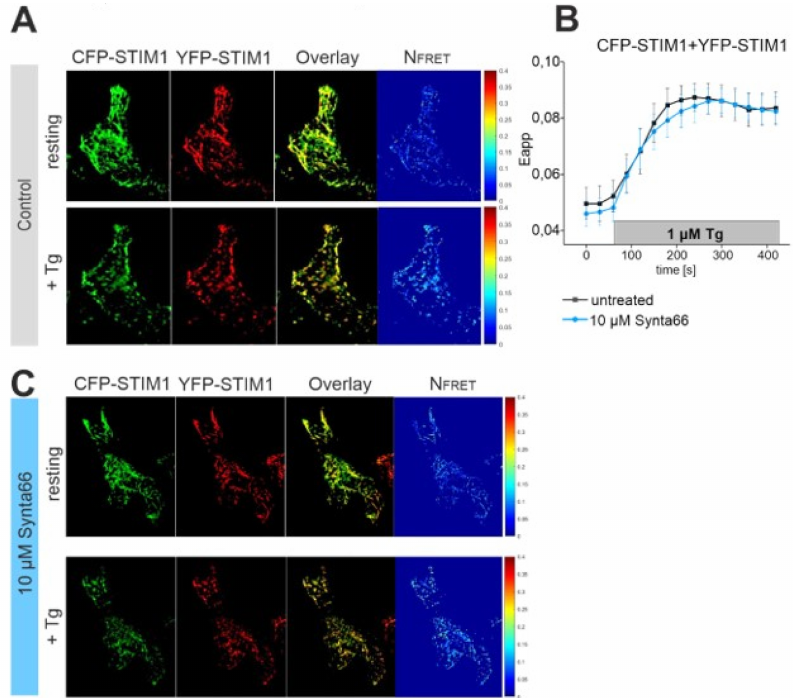
Figure 4. STIM1 interaction is not a ff ected by Synta66 : ( A ) Localization, overlay and calculated fluorescence resonance energy transfer (FRET) life cell image series of cyan fluorescent protein (CFP)-STIM1 and yellow fluorescent protein (YFP)-STIM1 in the absence (upper panel) and presence of Thapsigargin (TG, 1 µ M) mediated endoplasmic reticulum (ER) Ca 2 + store-depletion (lower panel). ( B ) Time-course of calculated FRET between CFP- and YFP-STIM1 with and without pre-treatment with 10 µ M Sytna66. ER Ca 2 + store-depletion was induced by 1 µ M TG. ( C ) Analogous experiments as in ( A ) upon incubation with 10 µ M Synta66 for 20